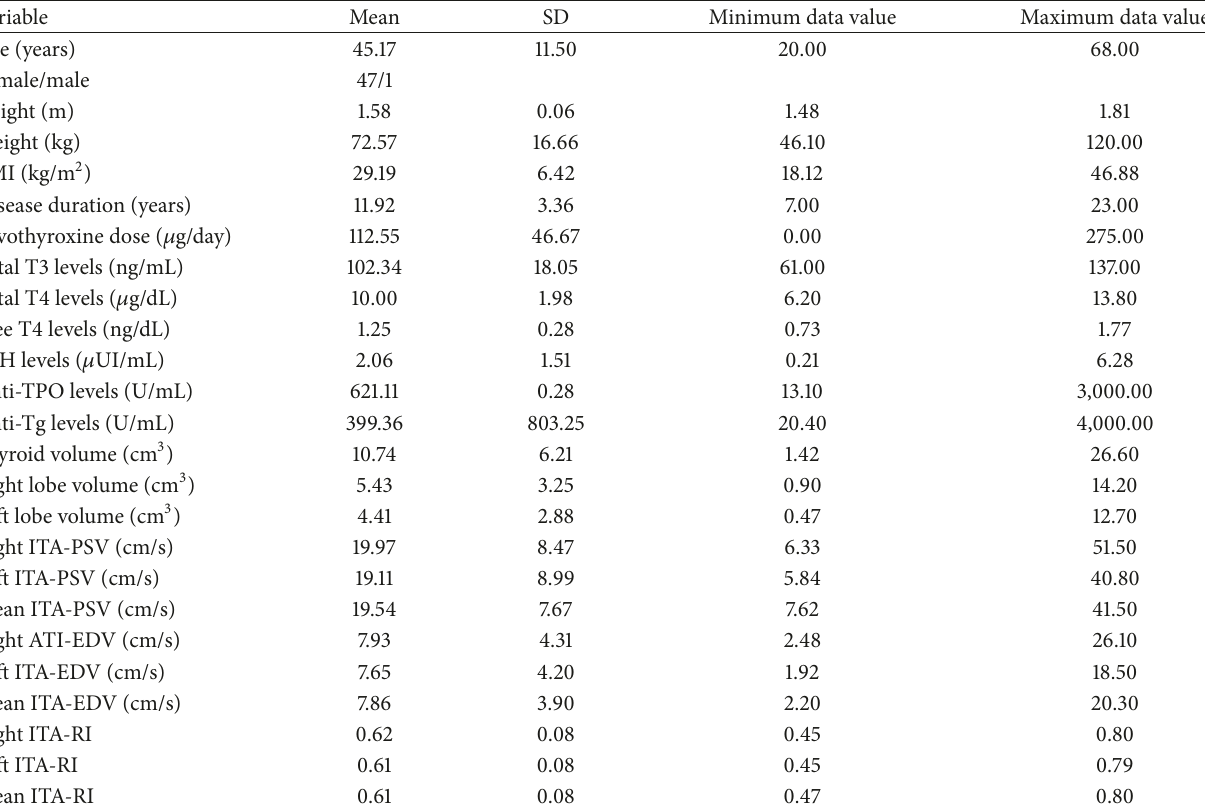
SD = standard deviation.